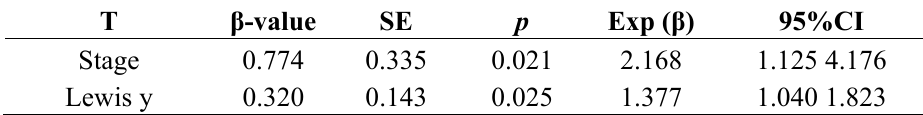
Table 4. Cox analysis of prognosis in ovarian cancer patients.